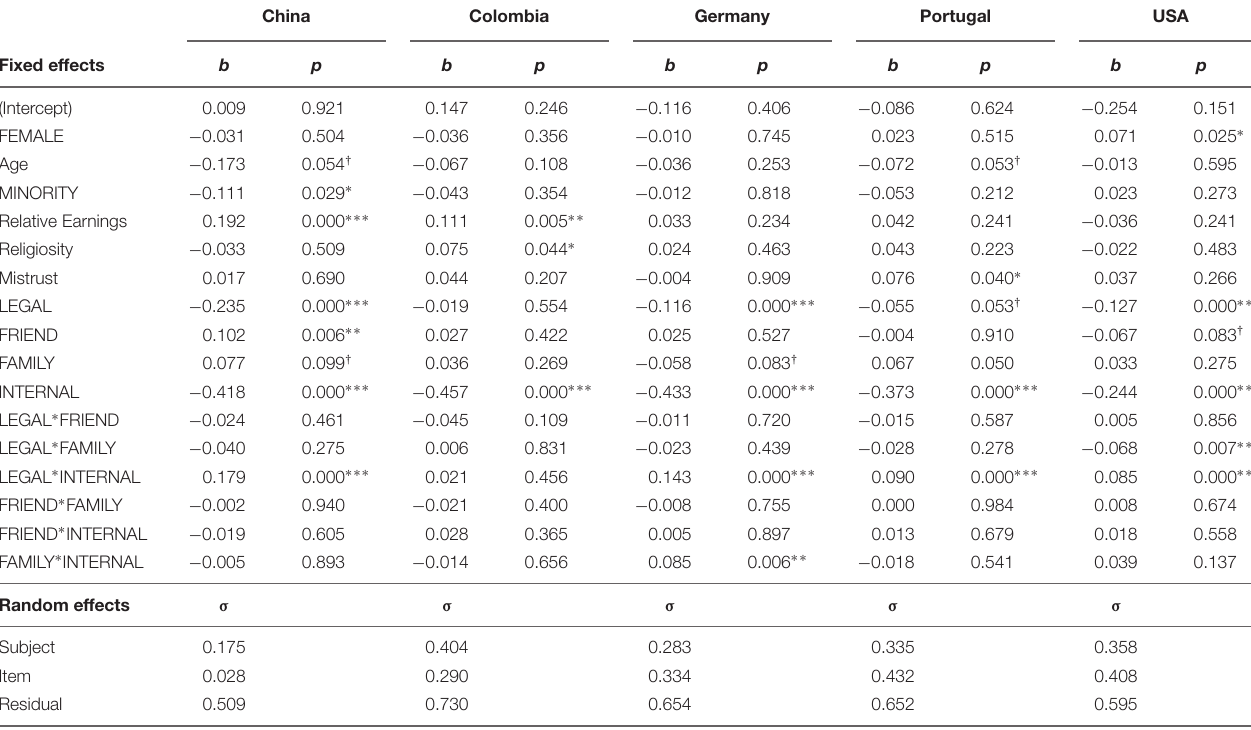
TABLE 4 | Results from linear mixed effects models (ML estimation) for likelihood of engaging in crime, conducted separately for each